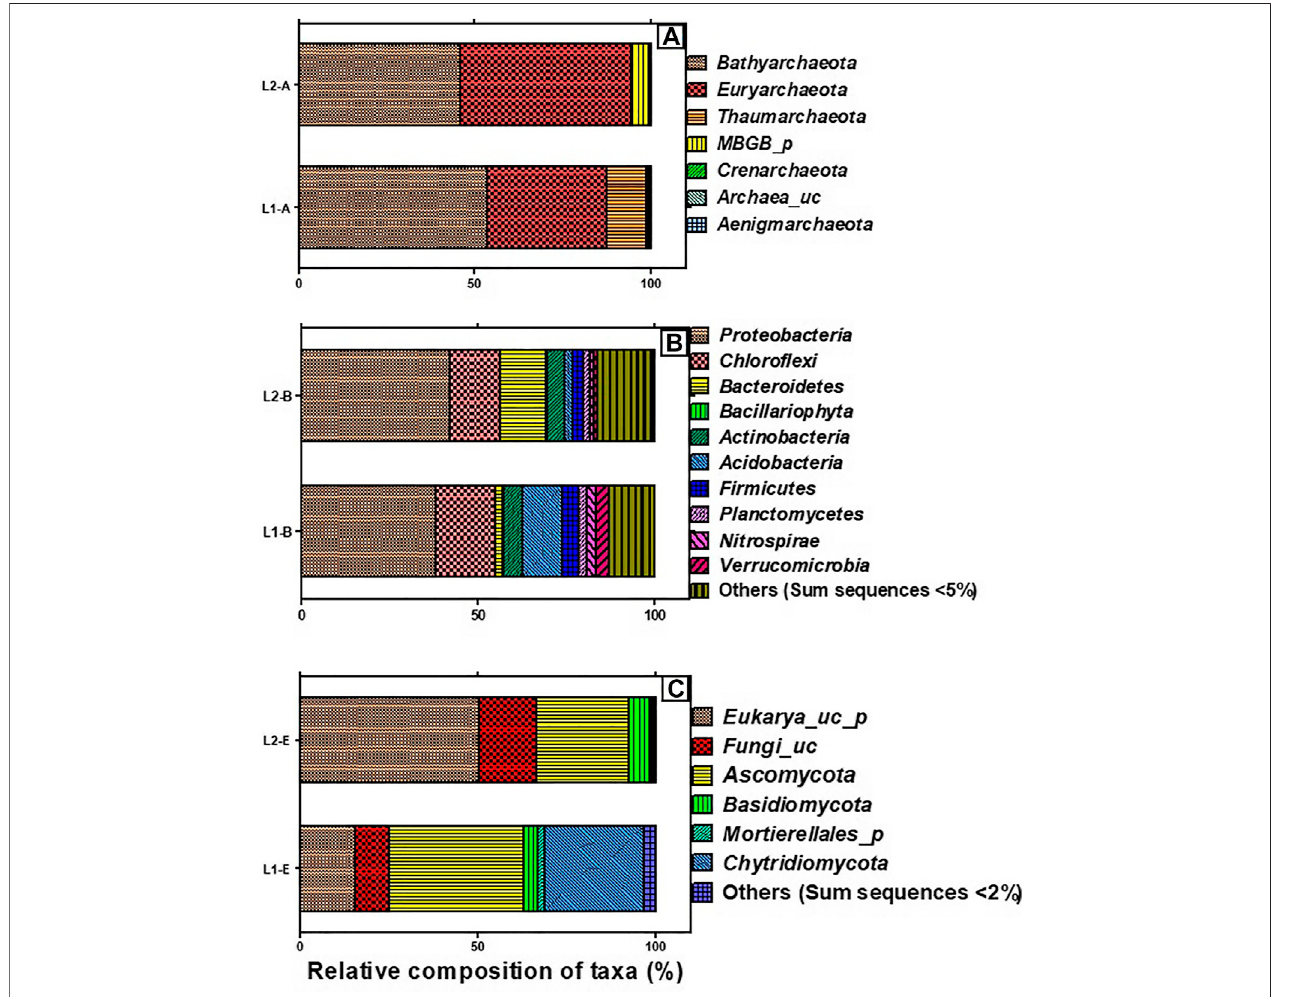
FIGURE 1 | Taxonomic composition of microbiome present in the sediments of the pristine environment (L1) and textile wastewater impacted freshwater (L2), showing the archaeal phyla (A) , bacterial phyla (B) , and fungal phyla (C) . Others represent the aggregation of phyla whose sum sequences are less than 5 and 2% in bacteria and fungi,